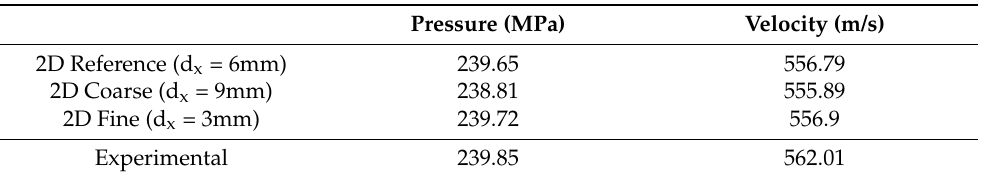
Figure 4. Numerical results for the mesh sensitivity analysis: ( a ) pressure evolution at the breech for different grid resolutions; ( b ) mesh representation. Table 3. Mesh sensitivity analysis: numerical results for absolute pressure and velocity of the projectile compared to experiments.